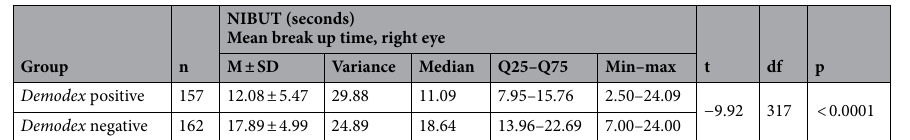
NIBUT (seconds) Mean break up time, right eye